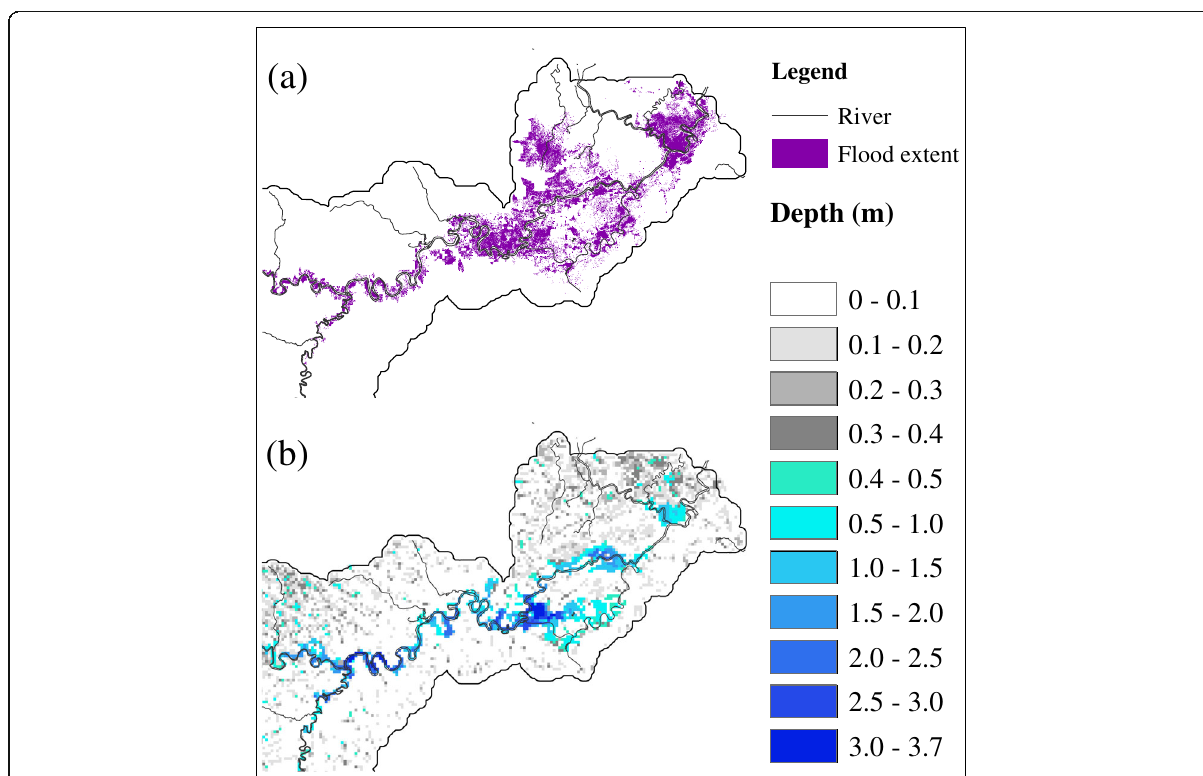
Fig. 7 Observation-based and simulated flood inundation maps for the downstream area. a Maximum flood extent captured by sentinel satellite and b simulated maximum inundation depth distribution with GSMaP Reanalysis